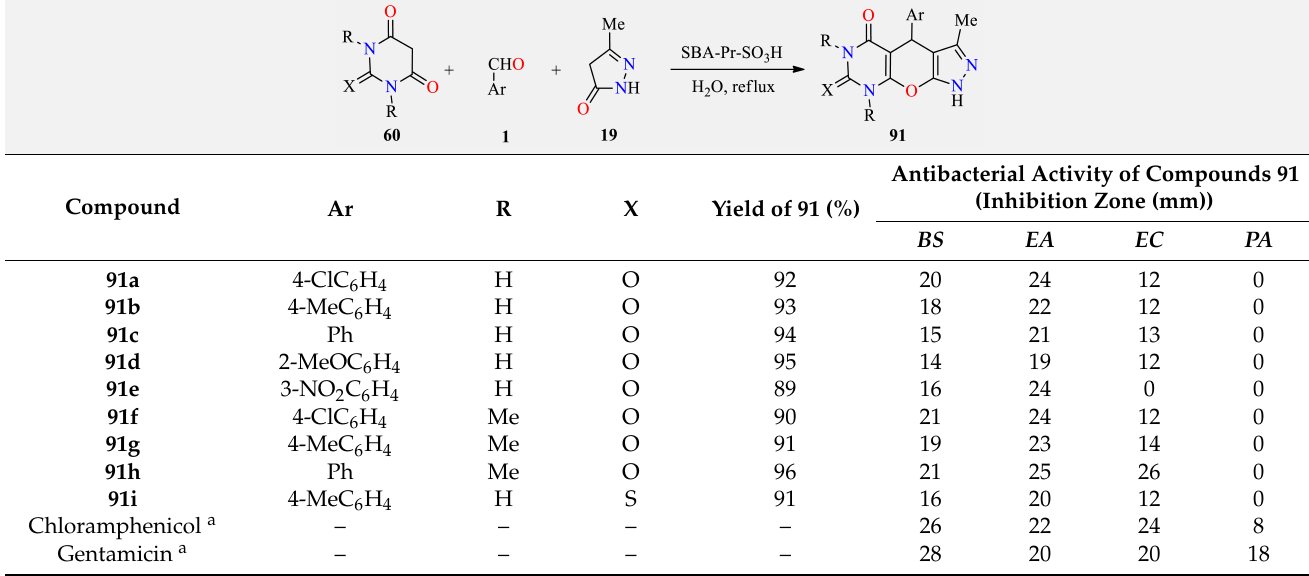
Table 25. SBA-Pr-SO 3 H-Catalyzed three-component synthesis of pyrazolopyranopyrimidines 91 and their in vitro antibacterial activity against four bacterial